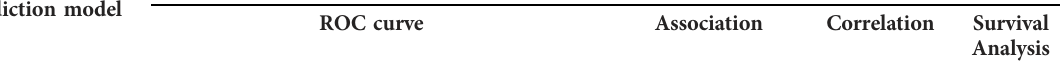
TABLE 6 Characteristics of the studies of mortality predictors in sepsis. Study